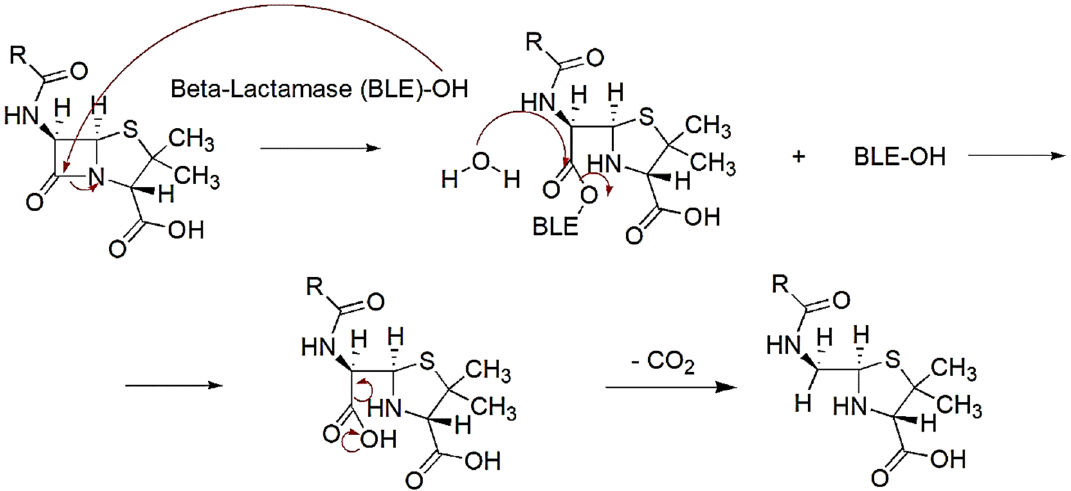
Scheme 1. Inactivation of BLAs through the hydrolytic action of SBLEs.